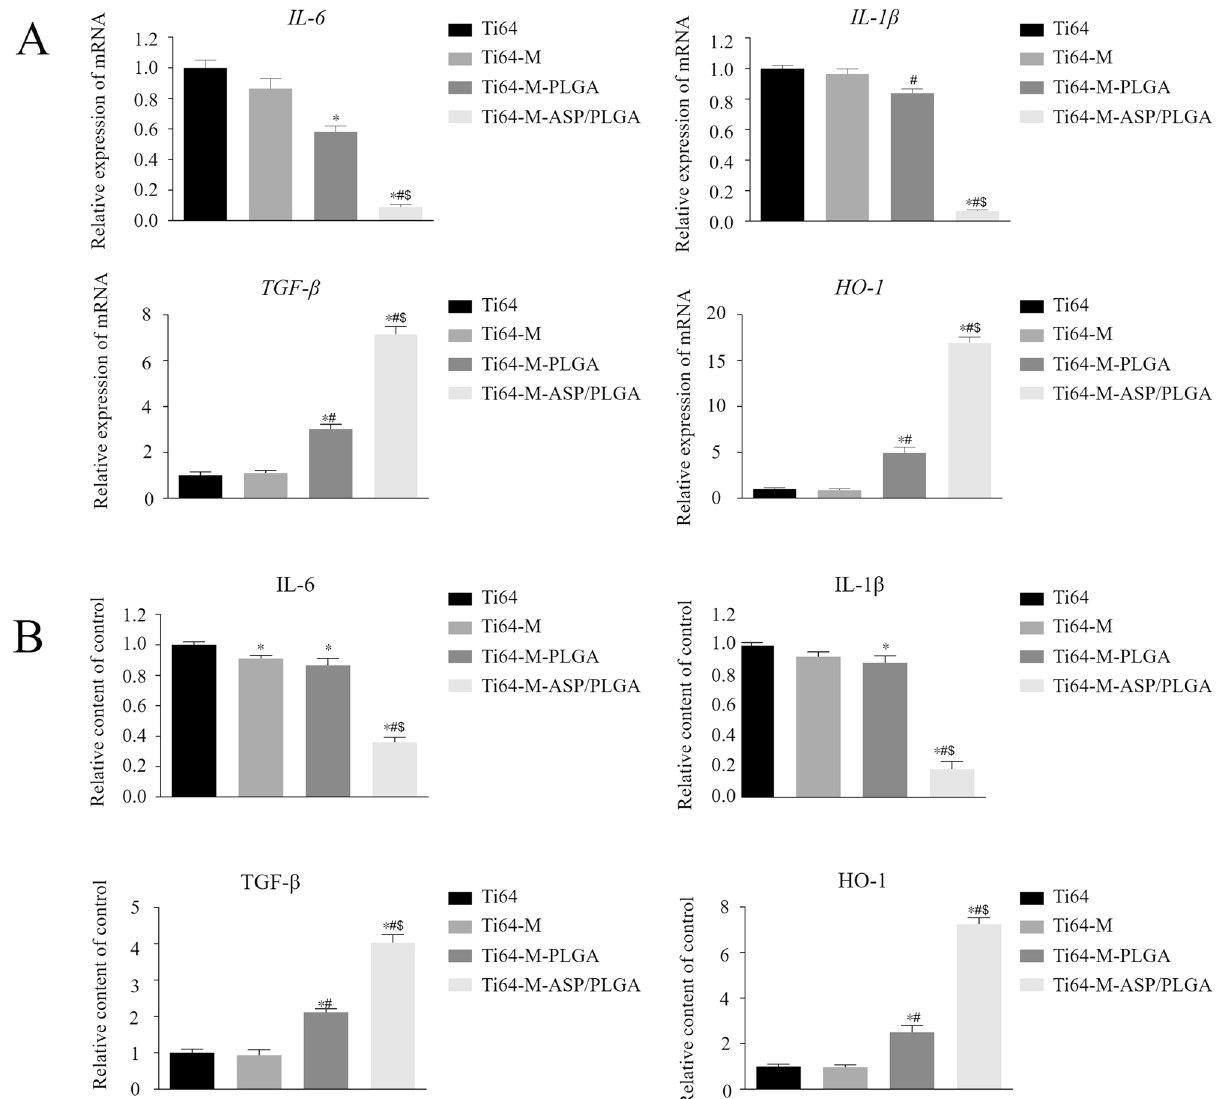
Fig. 4 Relative pro-in fl ammatory (M1) and pro-regenerative (M2) marker genes and proteins expression in RAW 264.7 macrophages cultured with different samples. Gene expression levels ( A ) and Pro- tein secretion level ( B ) of M1 and M2 markers after 3 days of